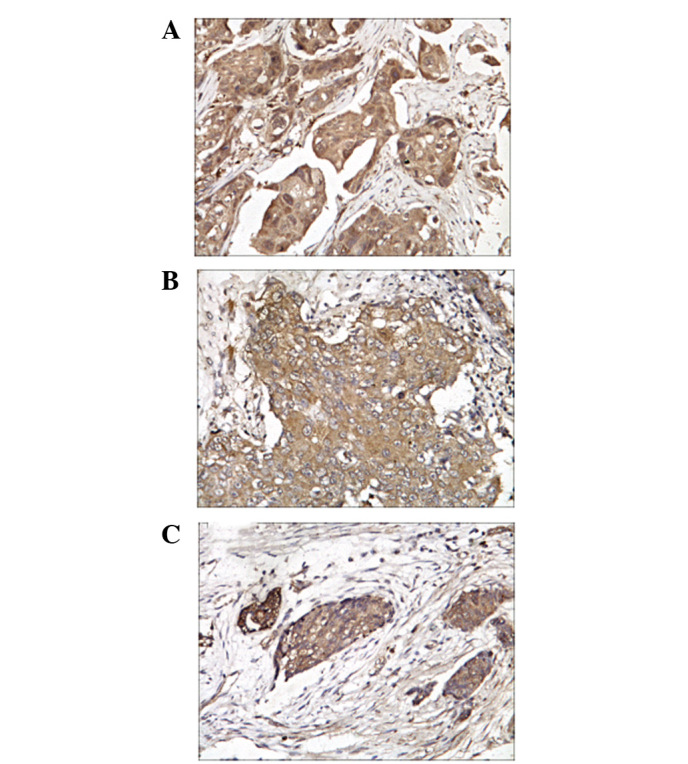
Immunohistochemical analysis of Twist, matrix metalloproteinase (MMP)-2 and MMP-9 protein expression in breast cancer. (A) Twist protein expression in the cytoplasm and nucleus of breast cancer cells; (B) MMP-2 protein expression and (C) MMP-9 protein expression in the cytoplasm of breast cancer cells. Original magnification, ×400.